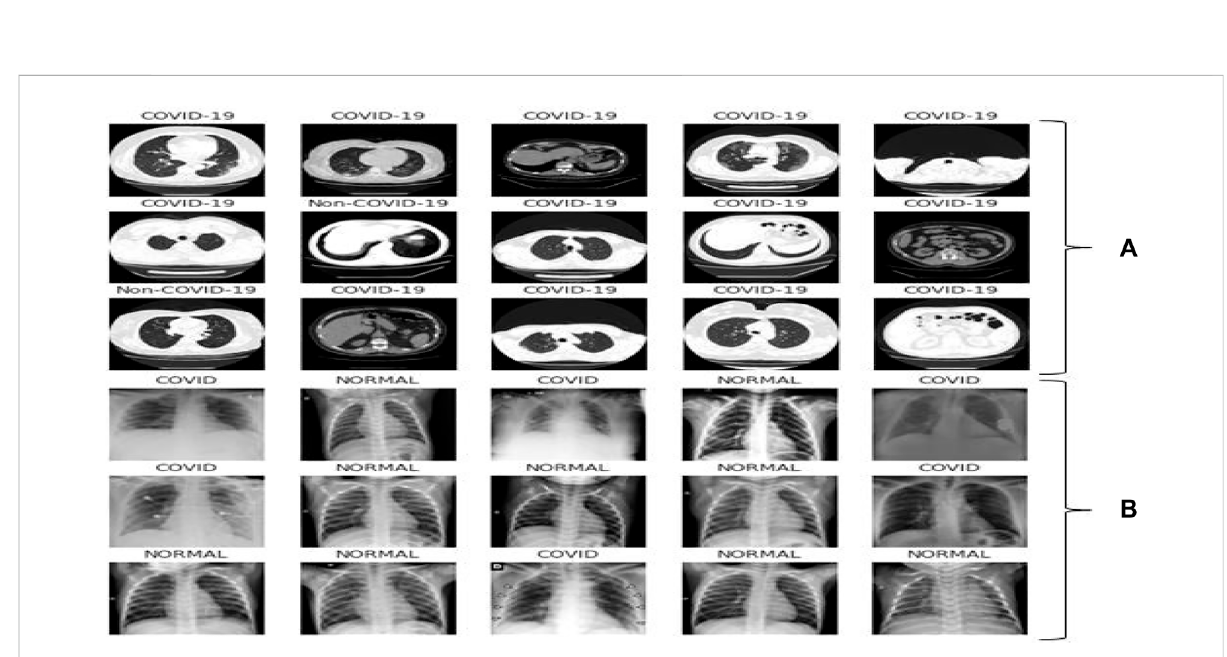
FIGURE 2 Representative samples: (A) CT scan samples from the dataset ARIA (2021), (B) X-ray samples from the dataset Siddhartha and Santra